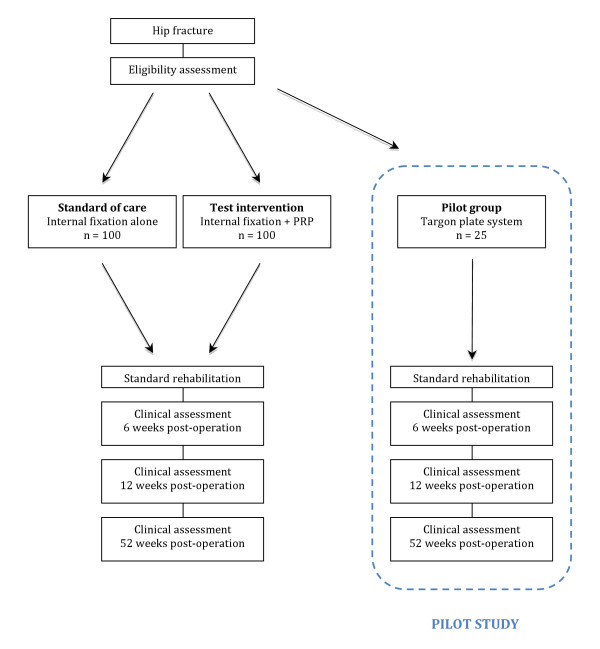
Trial flow diagram.